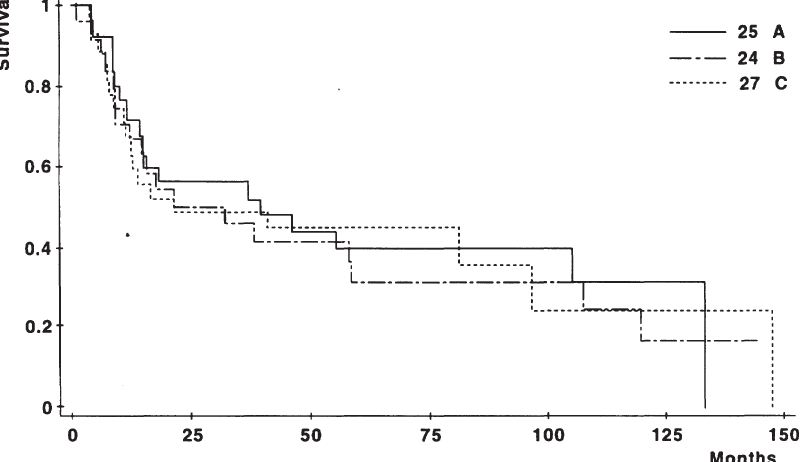
Fig. 1. Crude survival for PCNA expression. Patients were divided into three groups according to LI; group A: LI 14–47%, group B: LI 48–65% and group C: LI 66–93%. No statistically significant difference in crude survival was found between the groups.